Question: Express in one sentence what the figure is showing.
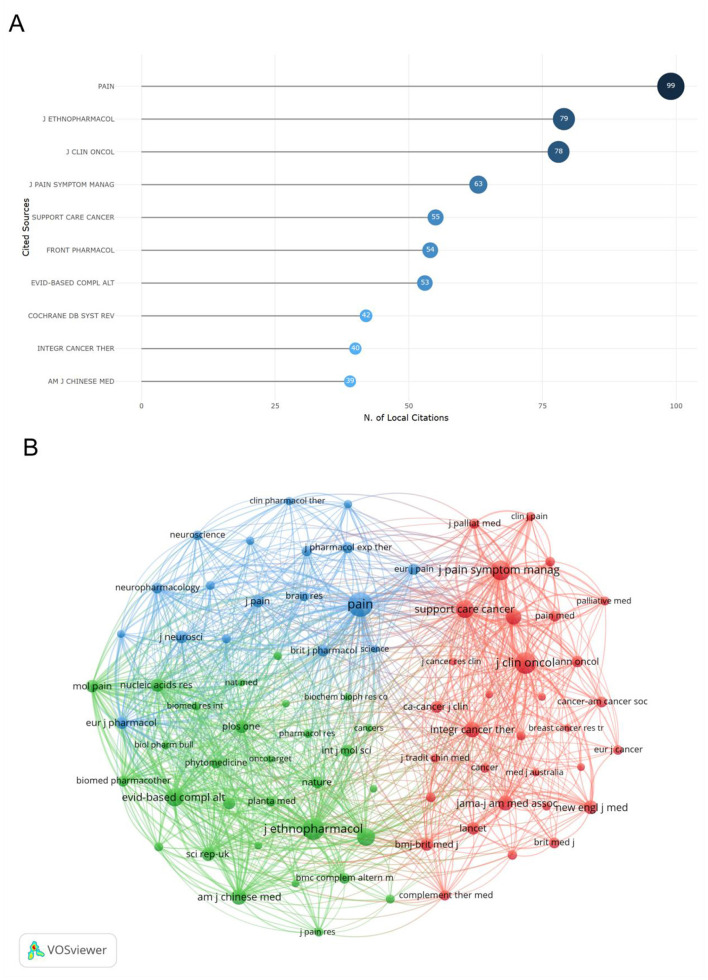
Answer: Distribution of co-cited journals. (A) Bar chart showing the top 10 most frequently co-cited journals ranked by local citation frequency. (B) Network visualization of co-cited journals. Each node represents a journal, with node size proportional to its co-citation frequency. Links indicate co-citation relationships, and different colors represent journal clusters with closely related citation patterns.